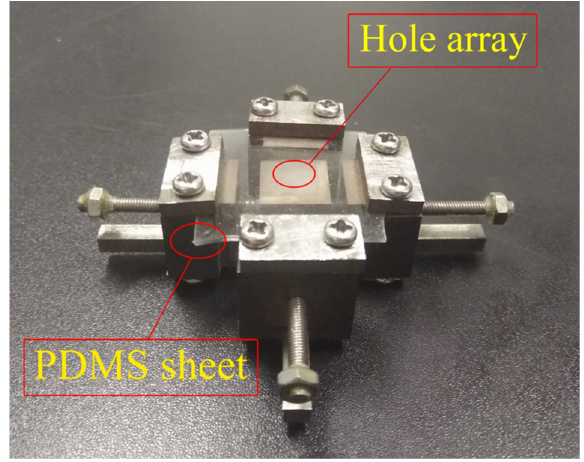
Figure 1. The tool used for stretching the sample.